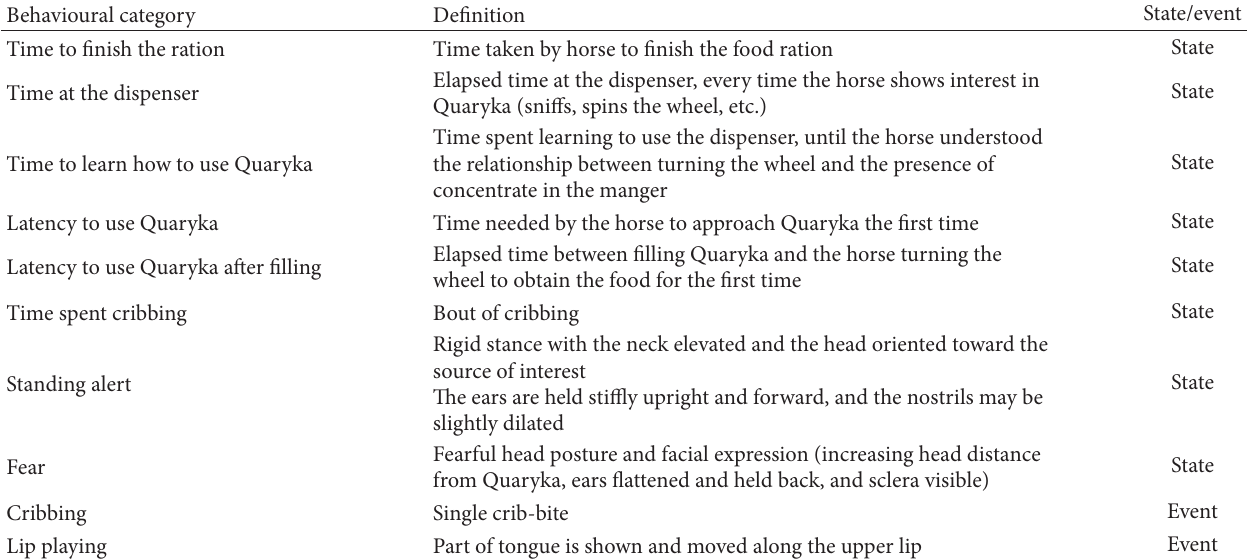
Table 1: Behavioural categories and definitions.